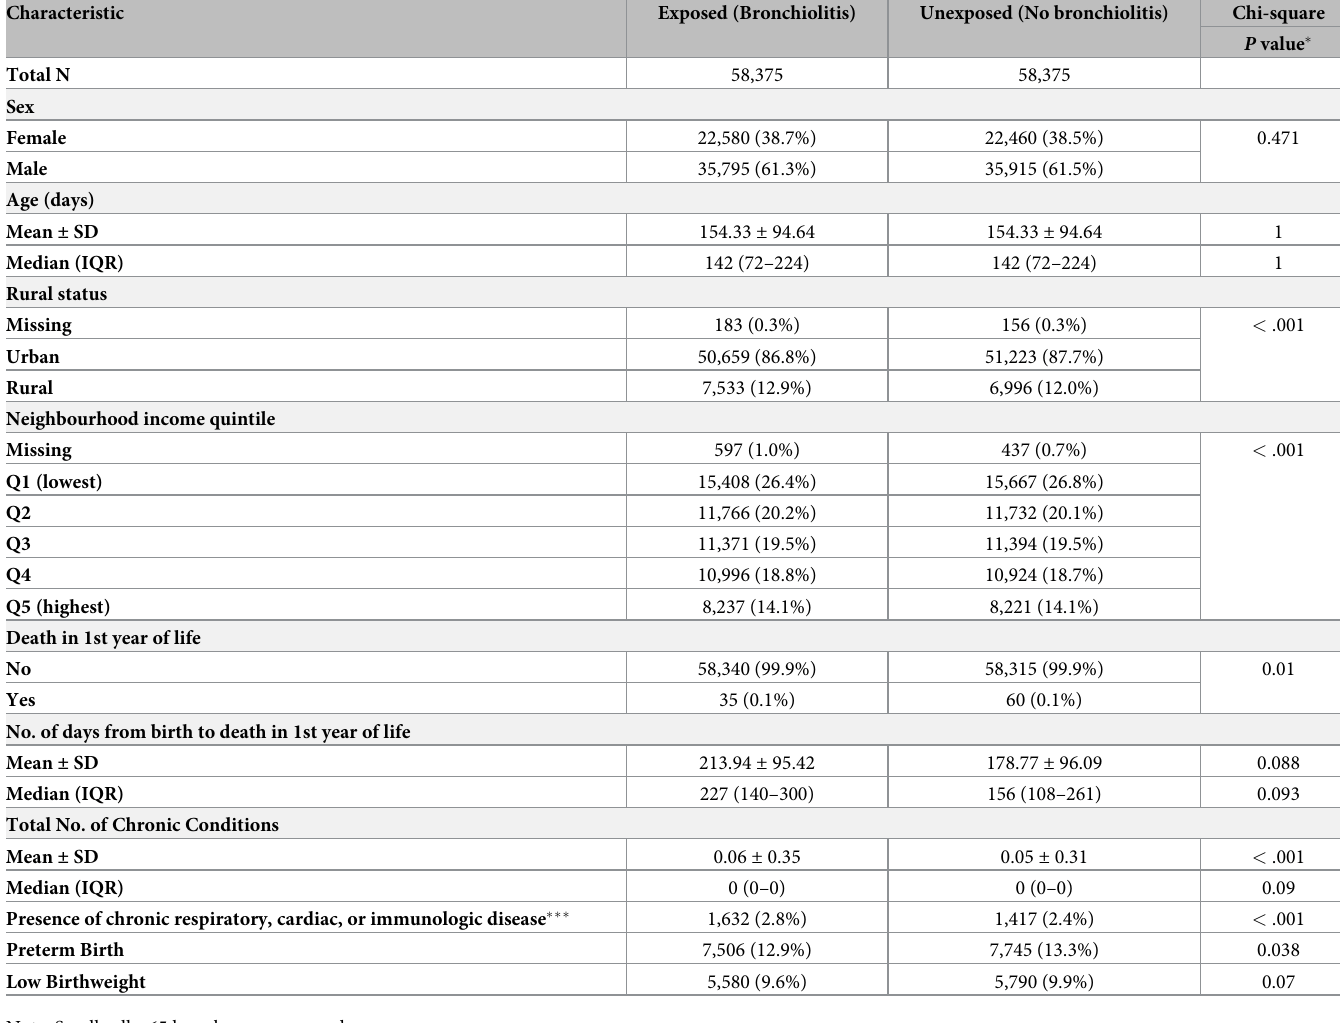
Table 1. Selected sociodemographic and clinical characteristics of study infants and their matched